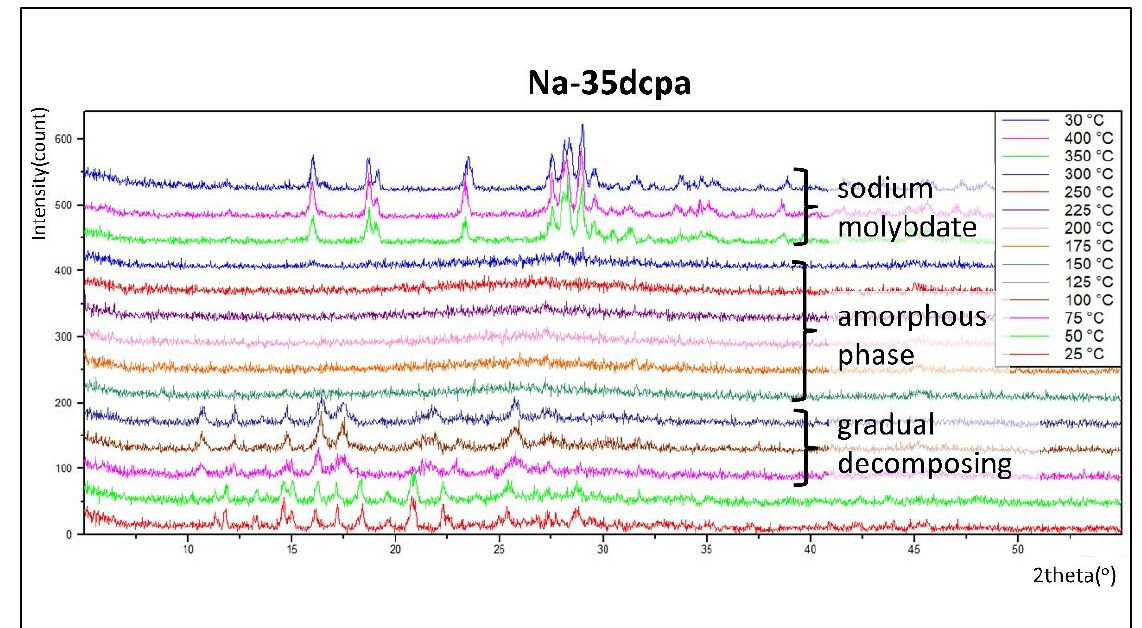
Figure 4. XRPD vs. temperature: thermal decomposition studies of the compound Na-35dcpa (see text for description). The estimated from Scherrer equation size of crystallites (initial phase 25 °C) was about ~75 nm (see Table S2 for details).